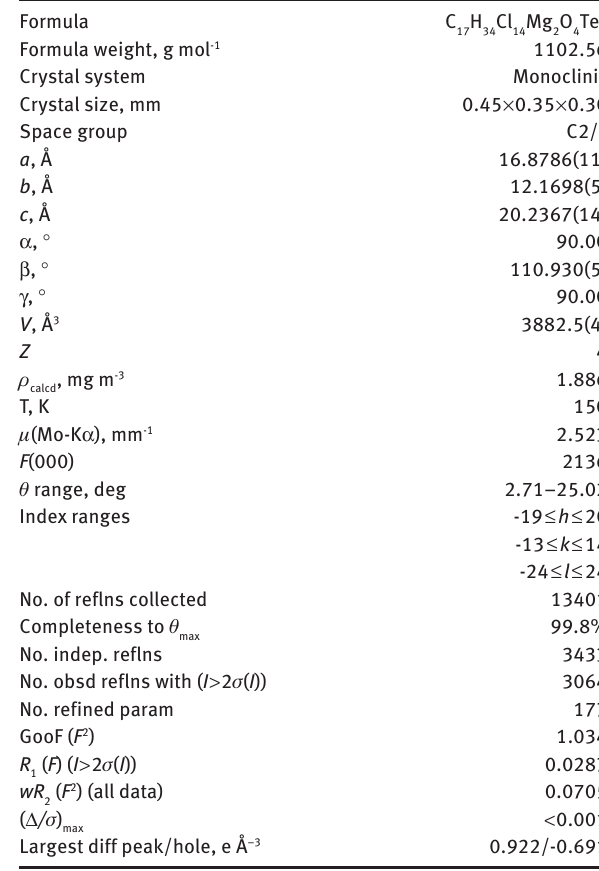
Mg ( μ -Cl 2 2 3 2